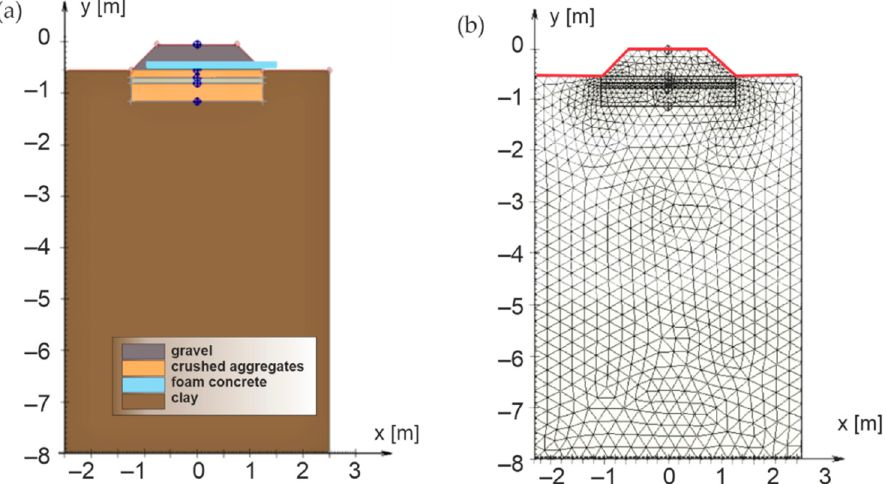
Figure 7. Numerical model of segment A of the experimental field ( a ) cross-section, ( b ) mesh.